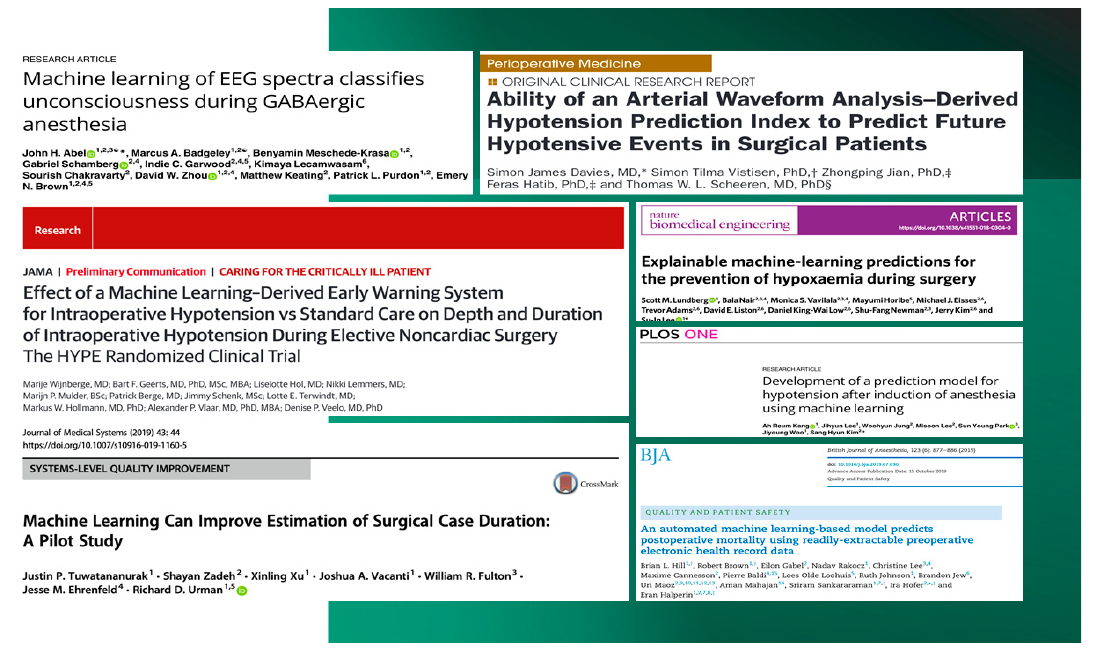
Figure A1. Collection of recent examples of applications of artificial intelligence to anesthesia, shown to interviewees after question 2.